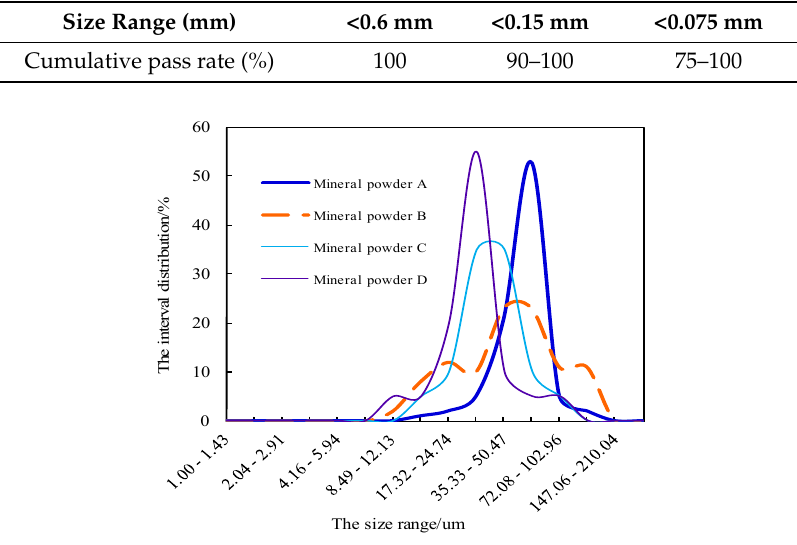
Figure 1. Difference in meso gradation of the four kinds of mineral powder.